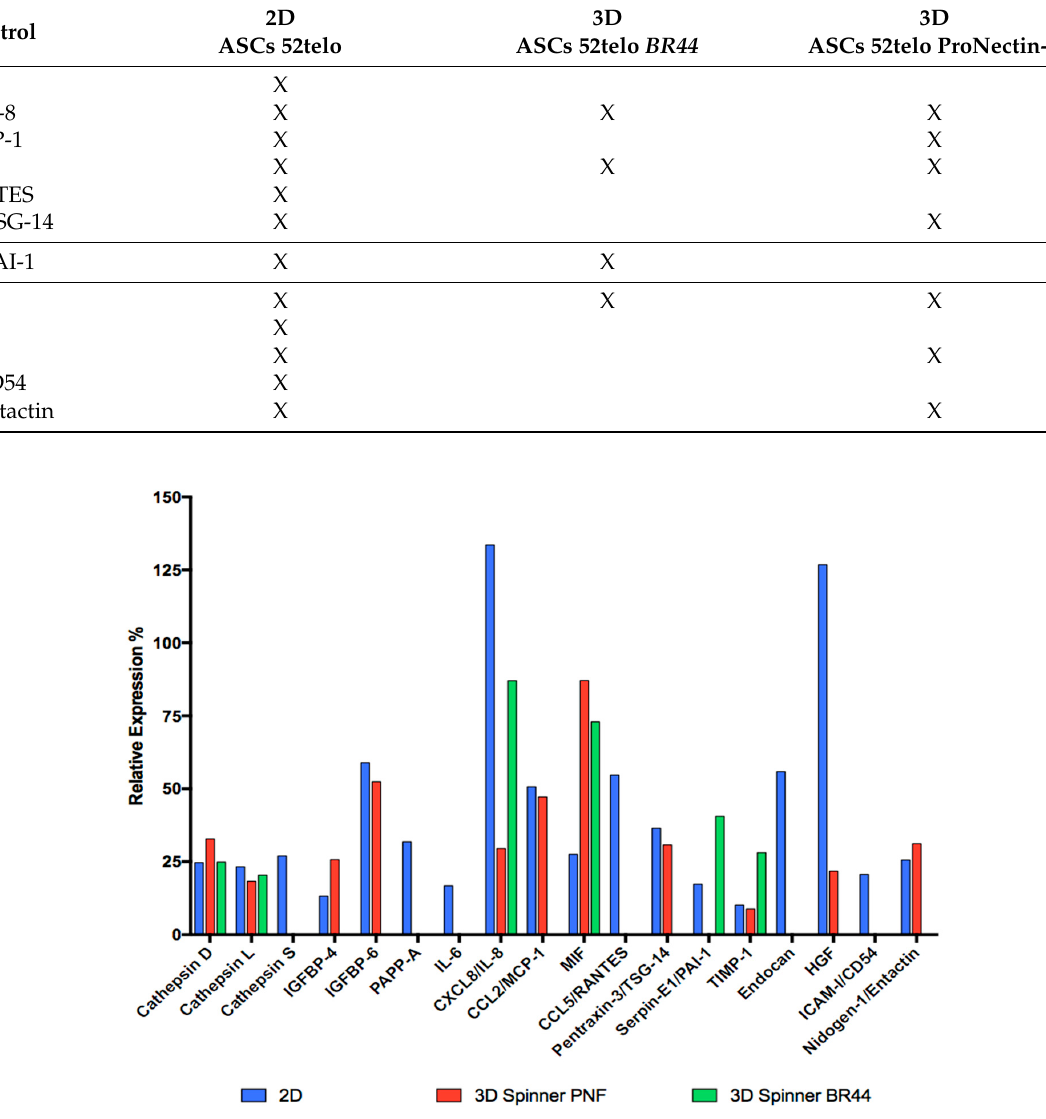
Figure 11. Comparison of the secretome profiles of ASC52telo cells cultured in standard cell culture vessels (2D) or dynamic conditions (spinner flask, 3D). In this latter case, the cells were cultured either on BR44 MC or commercial ProNectin-F MC. The calculated levels are expressed as a percentage relative to the reference spot present on the membrane. Remarkably, the secretion profile depends on the three culture conditions (2D, 3D spinner ProNectin-F, and 3D spinner BR44 ) tested in this study.